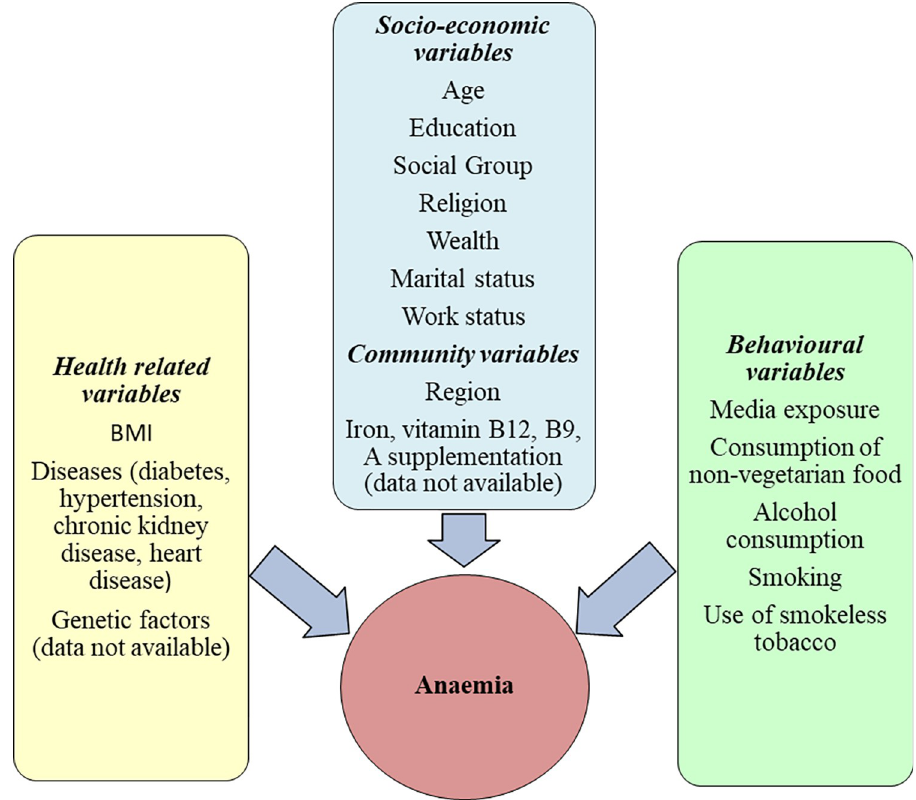
Fig 2. Conceptual framework showing factors affecting